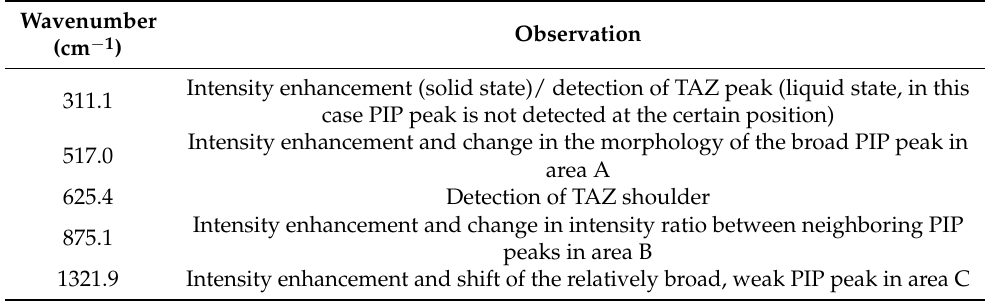
Table 2. Spectral differences between PIP and formulation Raman spectra obtained from either solid or liquid samples of the substances on a g.slide. TAZ presence accounts for such